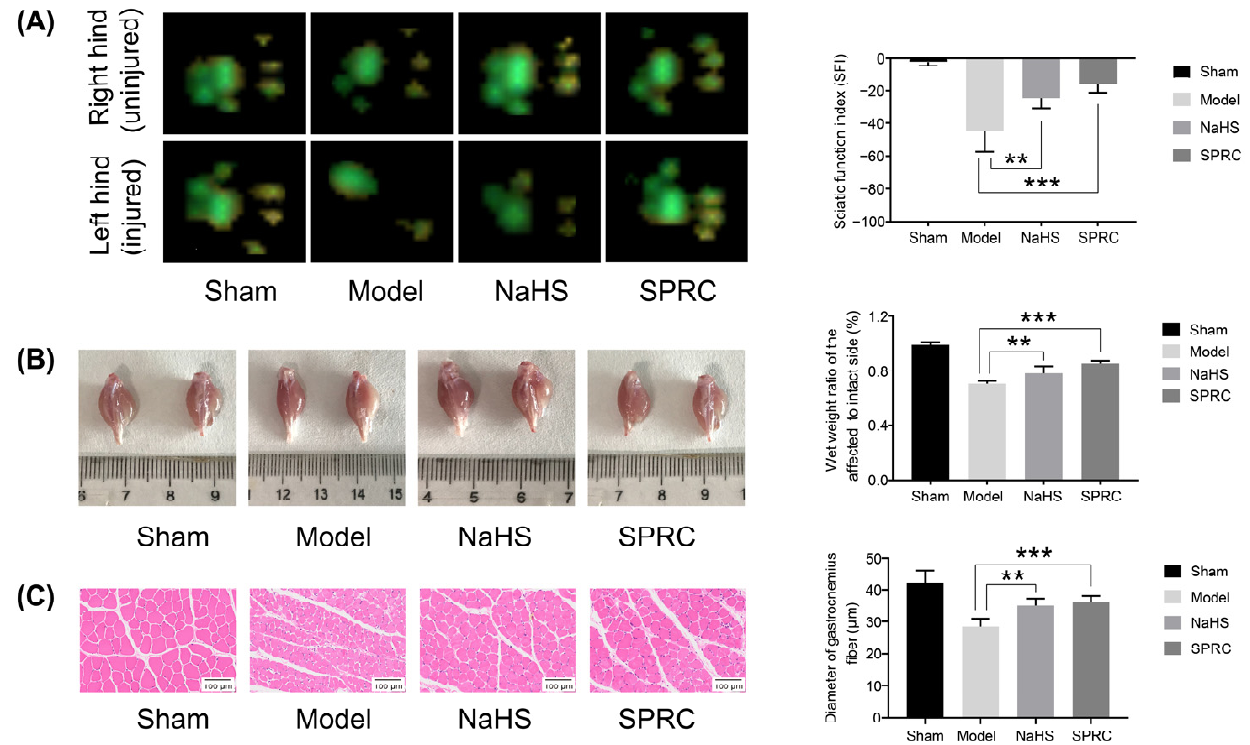
Figure 1. Gait analysis and gastrocnemius muscle assessments in mice at 2 weeks after surgery for each group. ( A ) Representative pawprint and statistical analysis of the sciatic function index (SFI). ( B ) Gross observation of injured (left) and uninjured (right) gastrocnemius muscles, and statistical analysis of wet weight ratio (the weight of the injured side divided by the uninjured side) of gastrocnemius muscles. ( C ) Cross sections images of gastrocnemius muscle by hematoxylin-eosin (HE) staining, and statistical analysis of quantification of gastrocnemius fibers diameter. Data were presented as mean ± SEM ( n = 5 mice). ** p < 0.01 vs. model group, *** p < 0.001 vs. model